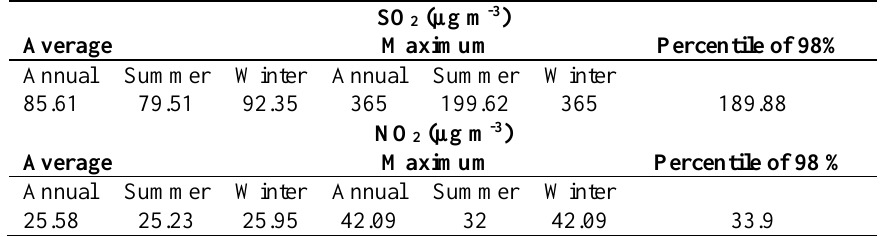
Table 1 SO 2 and NO 2 concentrations in different seasons